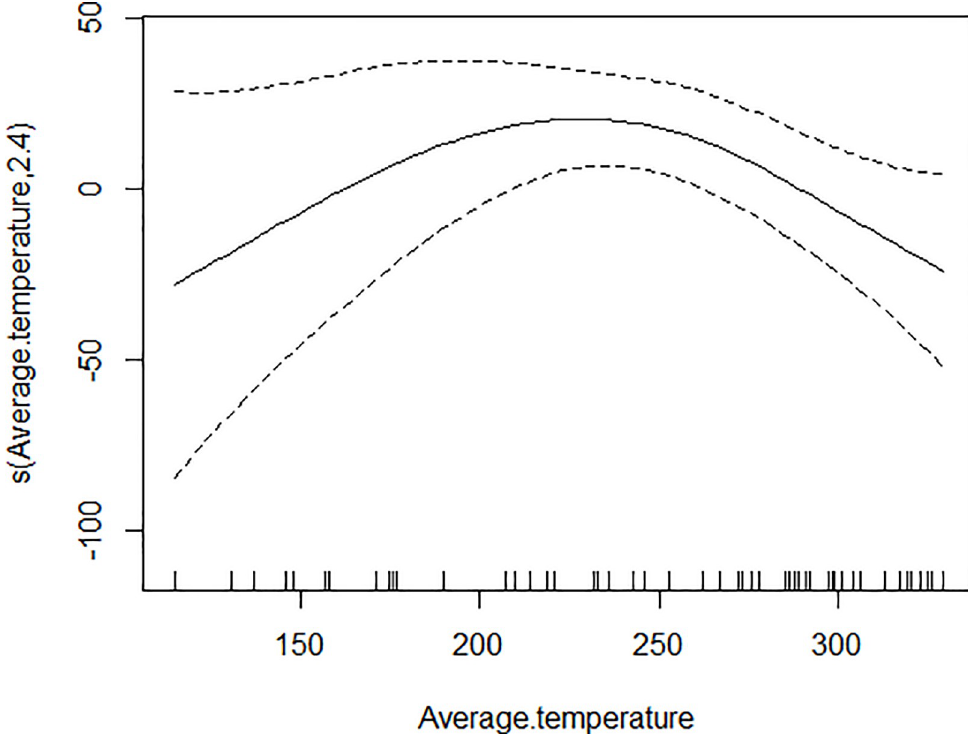
Fig 1. The relationship between BI and average